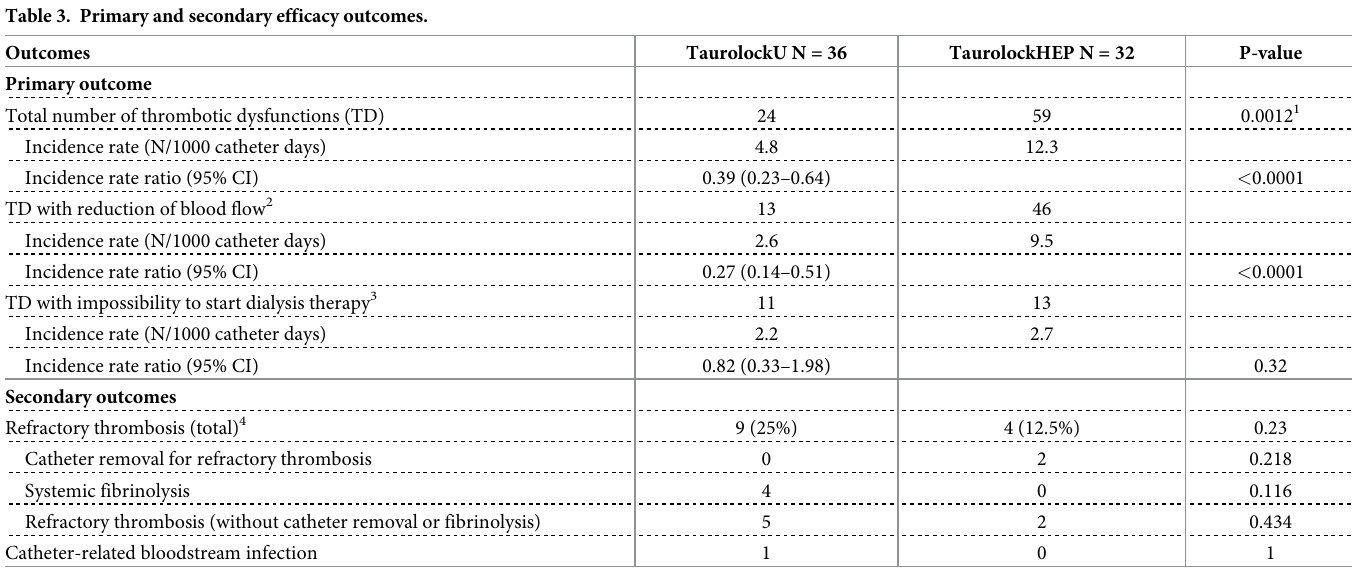
Table 3. Primary and secondary efficacy